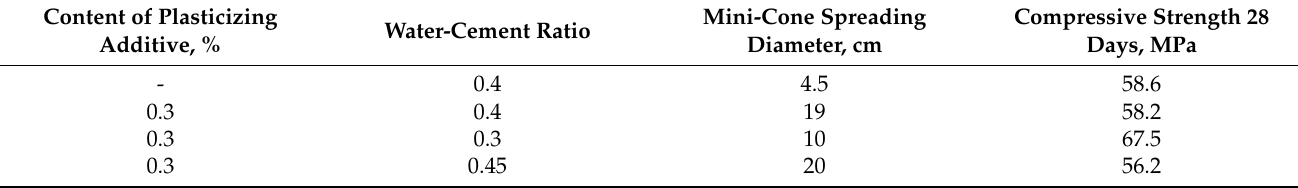
Table 1. Mechanical characteristics of cement compositions using 1,3,5-trihydroxybenzene-2-furaldehyde additive. Content of Plasticizing Additive, Figure 13. Dependence of the diameter of the mini-cone spreading on the dosage of 1,3,5-trihydroxybenzene-2-furaldehyde.